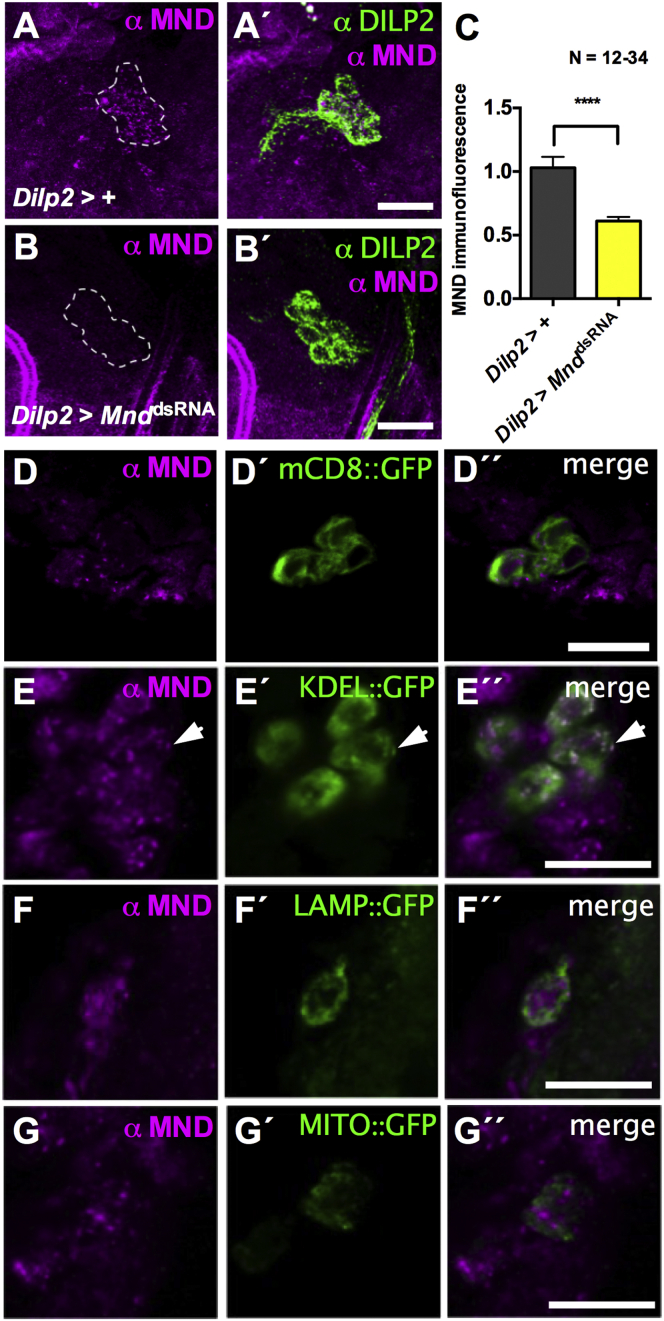
MND Leucine Transporter Is Expressed in Larval IPCs(A) Representative confocal images of whole mount larval IPCs labeled by anti-DILP2 (green) and anti-MND (magenta).(B) Mnd RNAi mediated by Dilp2-Gal4 reduces MND antibody signal.(C) Quantification of anti-MND immunoreactivity in IPCs.(D–G) Representative confocal images of larval IPCs expressing various intracellular compartment markers fused to GFP.(D) Anti-MND immunoreactivity partially co-localizes with the plasma membrane mCD8::GFP expression driven by Dilp2-Gal4.(E) Anti-MND signal overlaps with the ER marker (KDEL::GFP) driven by Dilp2-Gal4 (arrow).(F and G) Anti-MND signal does not overlap with a lysosomal marker (LAMP::GFP) (F) or a mitochondrial marker (MITO::GFP) driven by Dilp2-Gal4 (G).∗∗∗∗p < 0.0001: significant difference from control (t test); the data are mean ± SEM. The scale bar represents 20 μm.